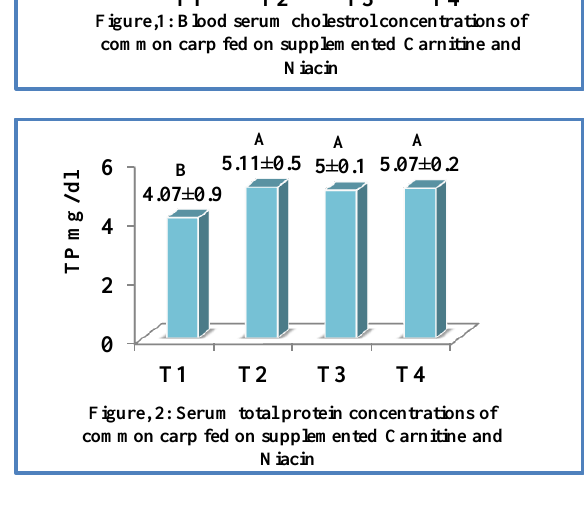
Figure,1: Blood serum cholestrol concentrations of common carp fed on supplemented Carnitine and